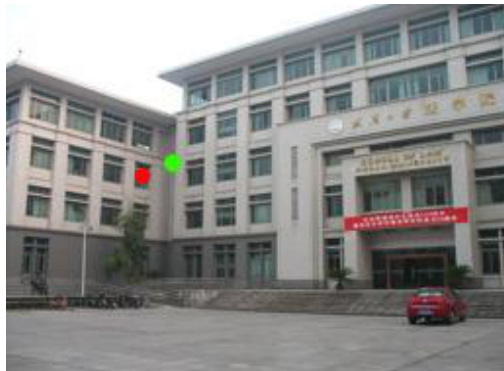
Figure 6: The estimated viewpoint (green point) of image I and its actual place (red point)